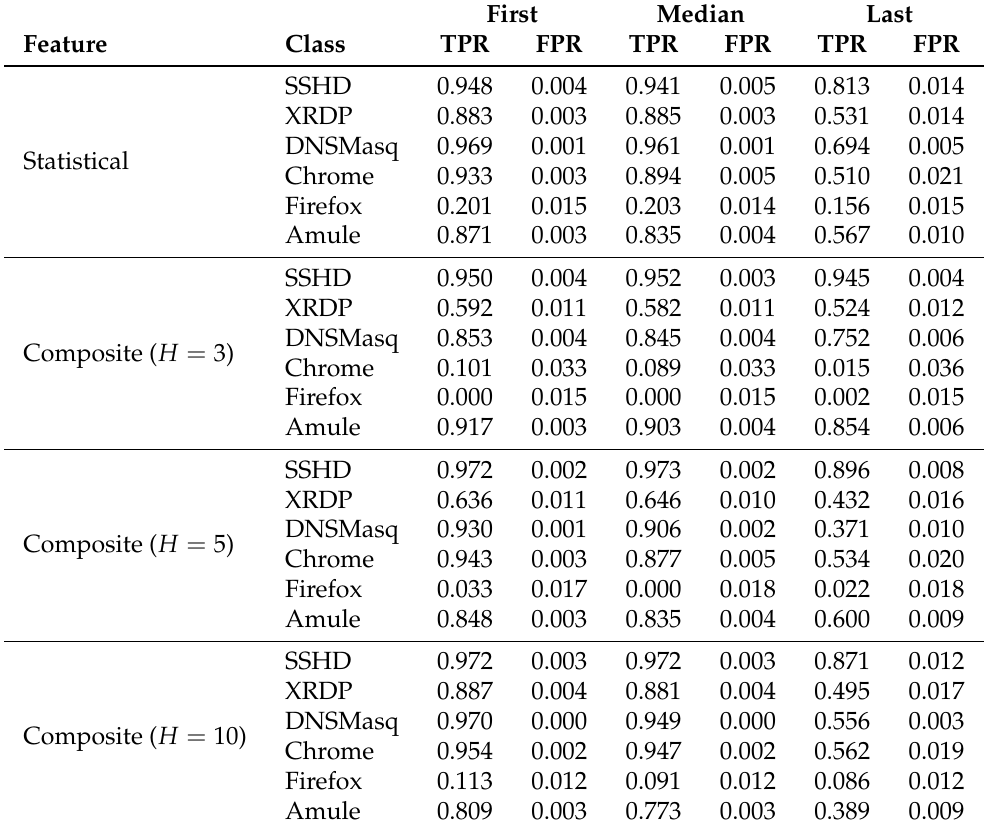
Table 16. Proposed method: Performance over UPC data set.